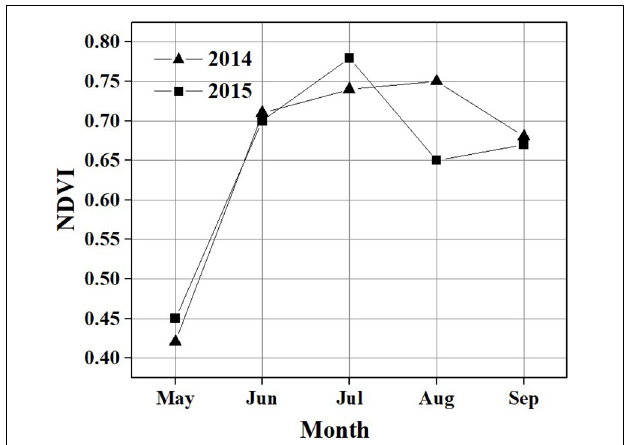
FIGURE 3 | Monthly variation in NDVI during the growing season in 2014 and 2015.